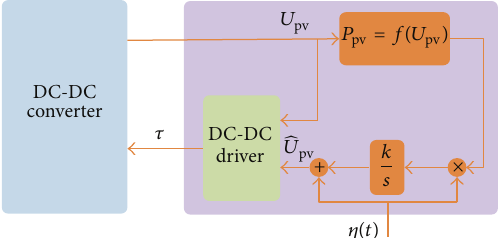
Figure 4: The structure of gradient-based extremum seeking MPPT